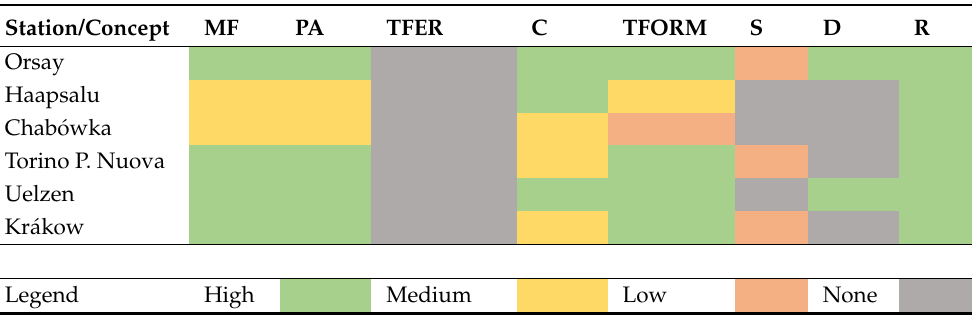
Table 5. Building configuration analysis. Degree of transformation. Own elaboration.